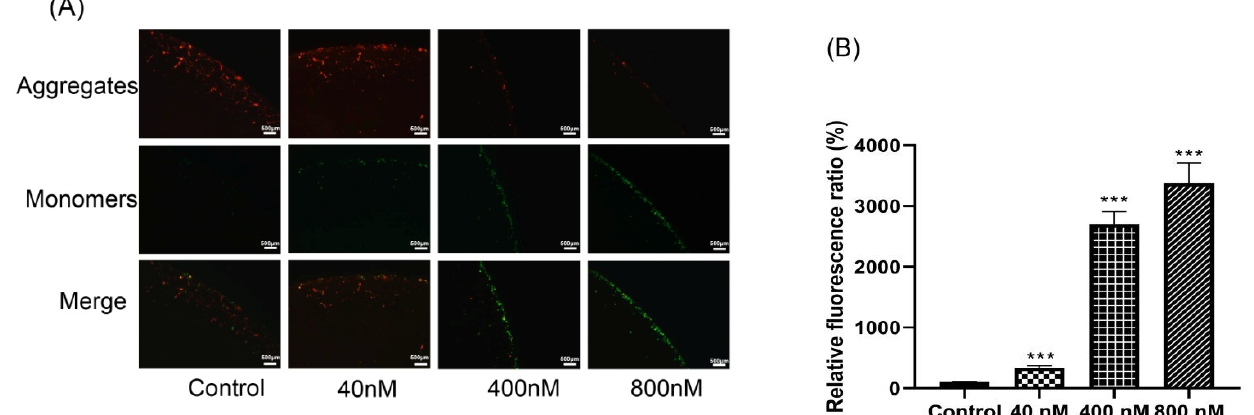
Figure 5. Effects of compound 3 to promote apoptosis of Huh-7 cells. Flow cytometry was used to detect the apoptotic cells by Annexin V/PI double-staining assay. ( A ) The pro-apoptotic effect of compound 3 (0, 40, 400 and 800 nM) in Huh-7 cells was analyzed by flow cytometry. ( B ) Apoptosis rates of the control group and compound group. Each value is the mean ± SD of three experiments. *** p < 0.001 vs. control group.